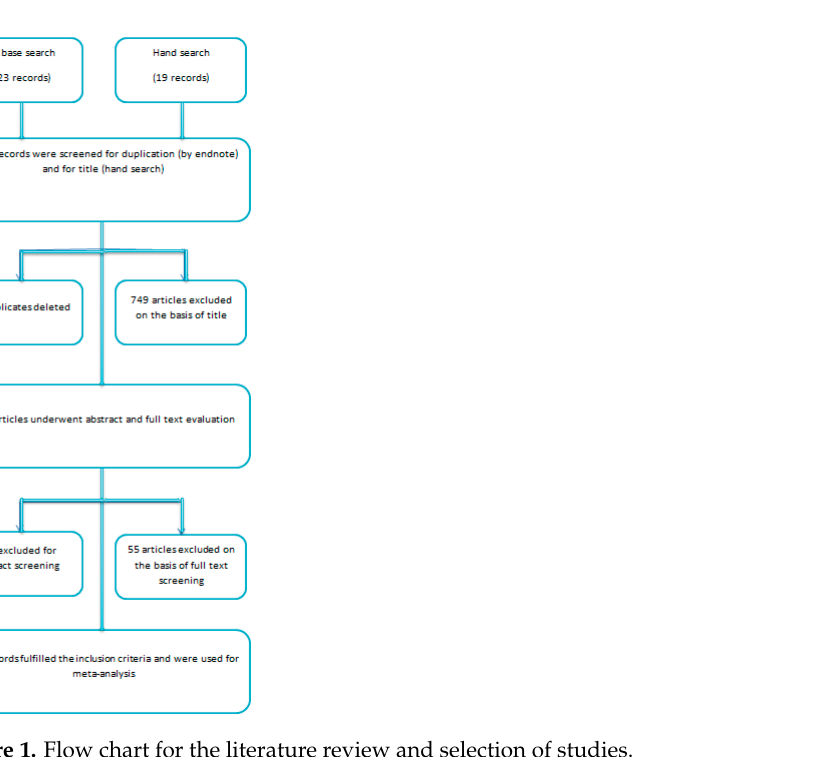
Figure 1. Flow chart for the literature review and selection of studies.